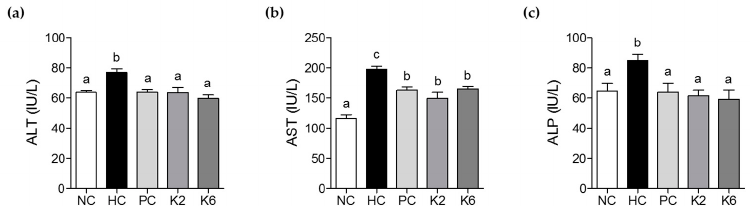
Figure 3. Effects of K2 and K6 on serum ALT, AST, and ALP levels in the rat model of HF/HF-induced